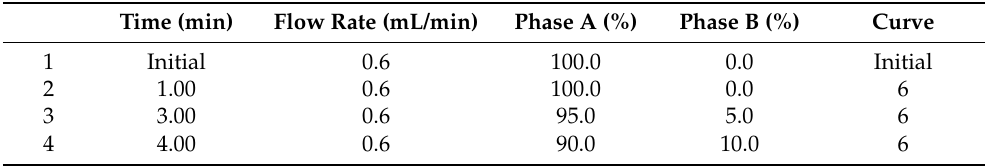
Table 1. Elution gradient for tryptophan determination by UPLC (phase A: water with 2% acetic acid; phase B: acetonitrile with 2% acetic